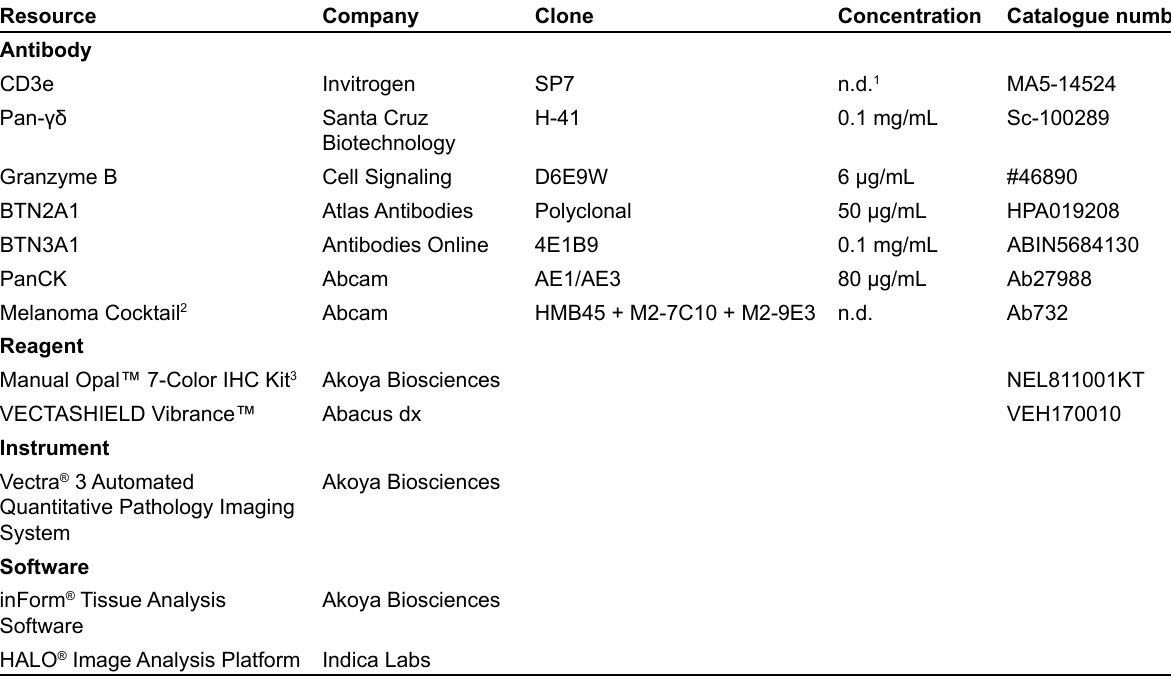
Table 1. List of necessary primary antibodies, reagents, instruments and software Resource Company Clone Concentration Catalogue